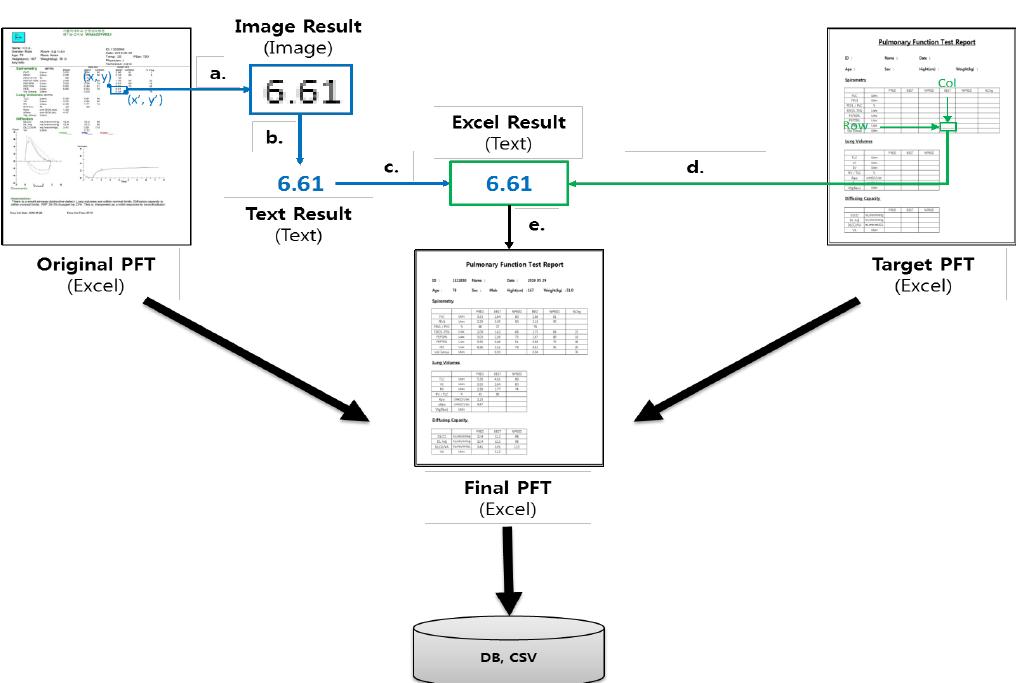
Figure 3. Data extractor algorithm functional process; a . measure x and y coordinate values from the